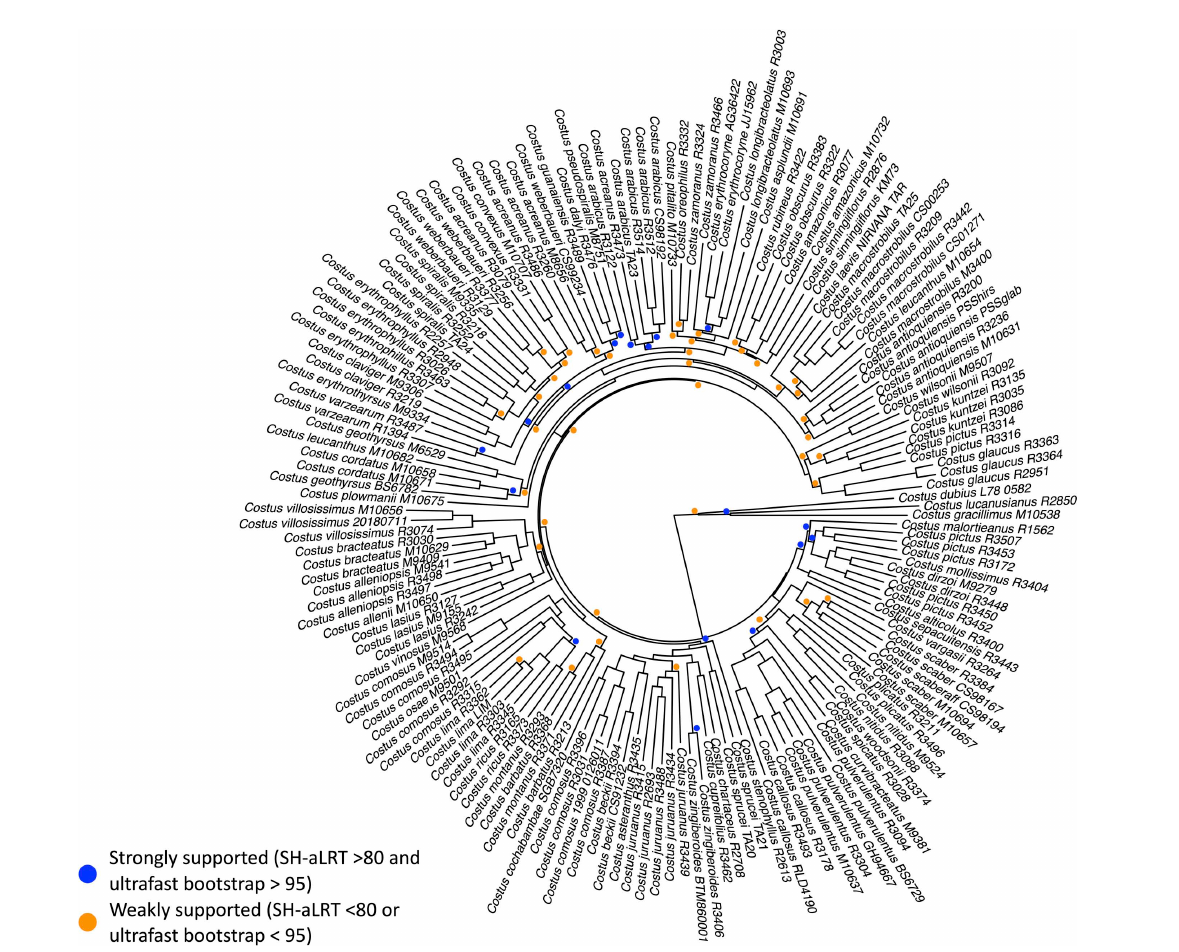
FIGURE1 Pruned maximum likelihood (IQtree) concatenation phylogeny of 945 loci. The values above the branches are the result of the SH-aLRT (above 80 are considered strongly supported) and ultrafast bootstrap support (above 95 are considered strongly supported) showing high support values in most of the branches. Support values are 100/100 unless otherwise specified. Well-supported SH-aLRT ( > 80) and ultrafast bootstrap ( > 95) are denoted with a blue circle, while support values of either SH-aLRT or ultrafast bootstraps lower than the strongly supported cutoff are denoted with an orange circle. African Costus and Neotropical Costaceae accessions used as outgroups are not